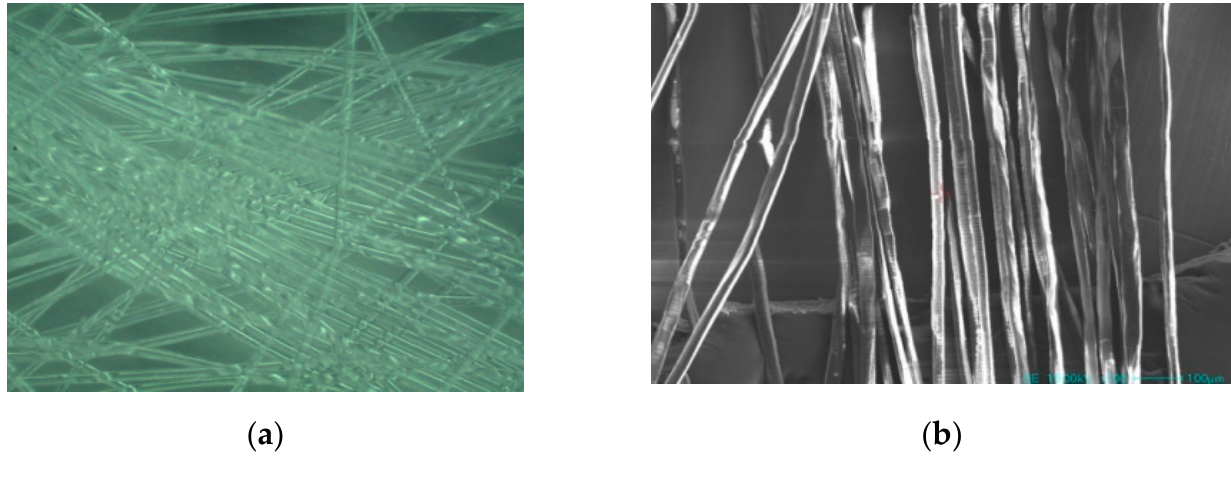
Figure 2. The microscopic images of PE fibers. ( a ) Optical microscope image; ( b ) SEM image (SE 1500 kV ×100).